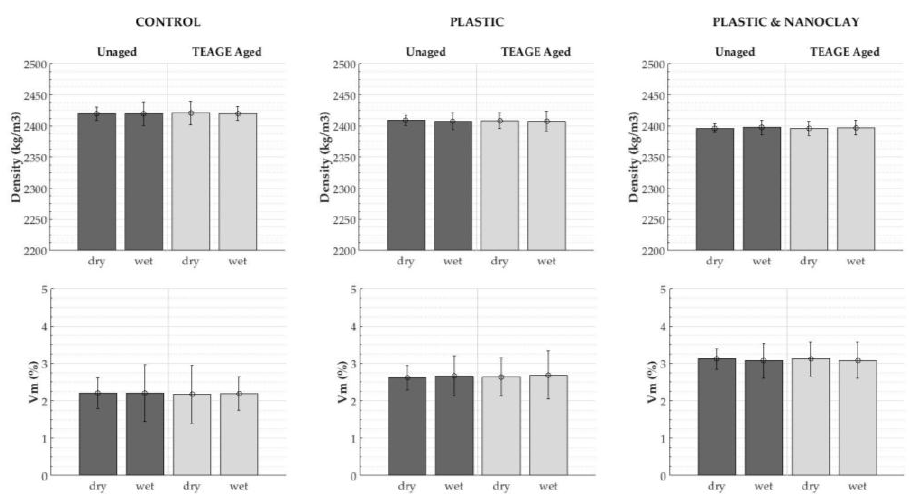
Figure 5. Bulk density and air voids content results for each AC mixture and set of specimens (dry/wet and unaged/aged).